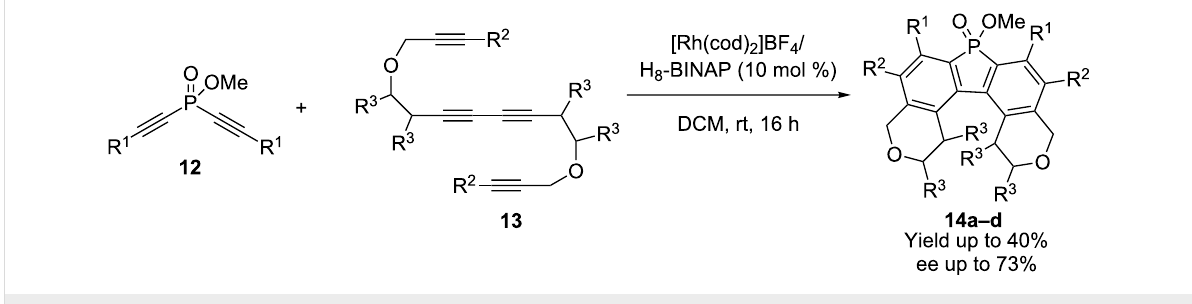
Scheme 6: Rhodium-catalyzed double [2 + 2 + 2] cycloaddition.